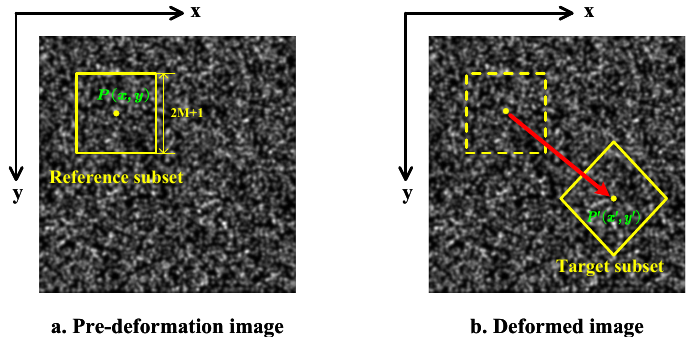
Figure 1. Related principles of integer-pixel search: ( a ) pre-deformation image; ( b ) deformed image. Common correlation functions are usually based on cross-correlation and distance- based correlation. Based on the cross-correlation function, there are cross-correlation function (CC), normalized cross-correlation function (NCC) and zero-mean normalized cross-correlation function (ZNCC). The distance-based cross-correlation functions are sum of squared distance correlation function (SSD), normalized sum of squared distance cor- relation function (NSSD) and zero-mean normalized sum of squared distance correlation function (ZNSSD). CC and SSD functions are more sensitive to light intensity changes and light shifts, while NCC and NSSD are more sensitive to light shifts. These four functions have poor anti-interference. On the other hand, ZNCC and ZNSSD have been de-averaged and normalized, which are insensitive to light intensity changes and light shifts and have high anti-interference and stability [52,53]. At the same time, ZNCC is computationally efficient and ZNSSD facilitates derivation and first-order Taylor expansion [42]. To sum